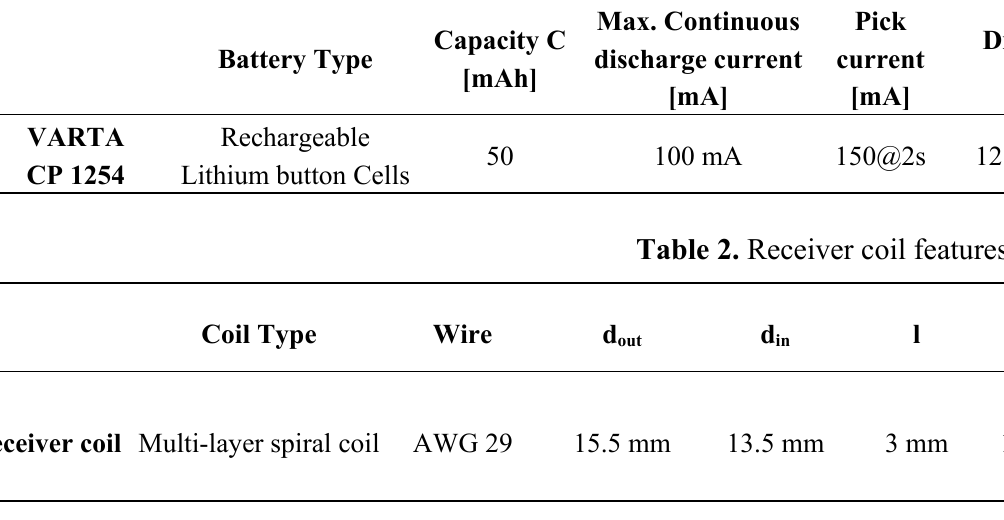
Table 1. Capsule battery requirements.